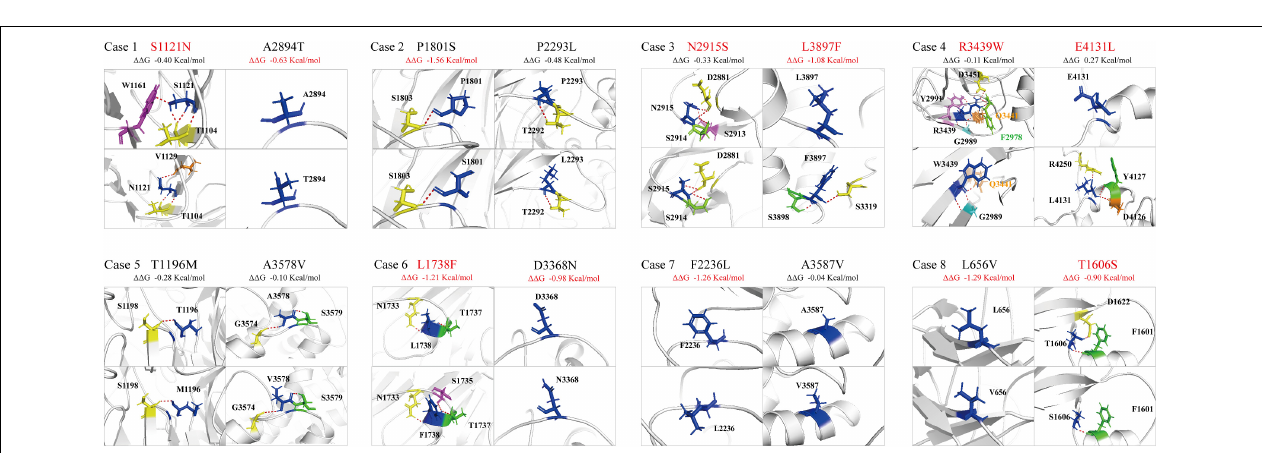
FIGURE 2 | Schematic illustration of the PC1 and locations of the PKD1 mutations identified in this study.